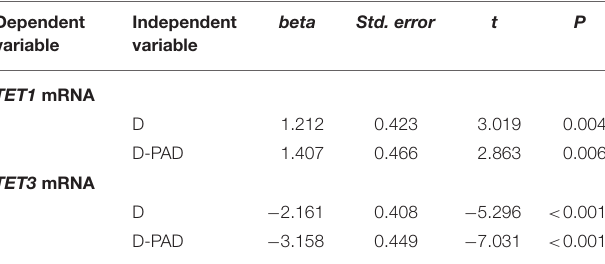
TABLE 3 | Multiple linear regression analysis to compare the TET1 and TET3 mRNA levels in ND group with that in D and D-PAD groups.